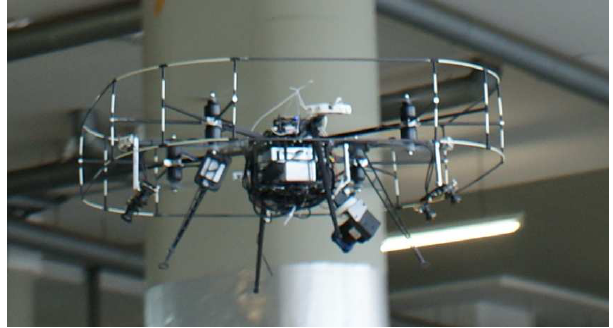
Figure 1: The 3D laser scanner mounted on our